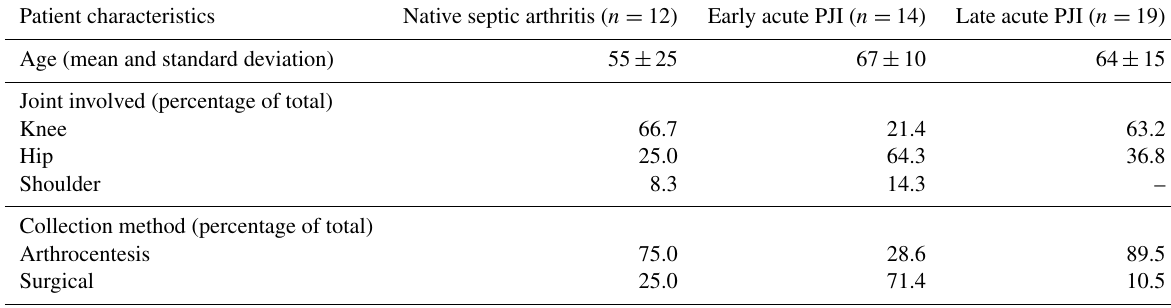
Table 1. Characteristics of patients with a clinical suspicion of native septic arthritis, early, or late acute PJIs. Patient